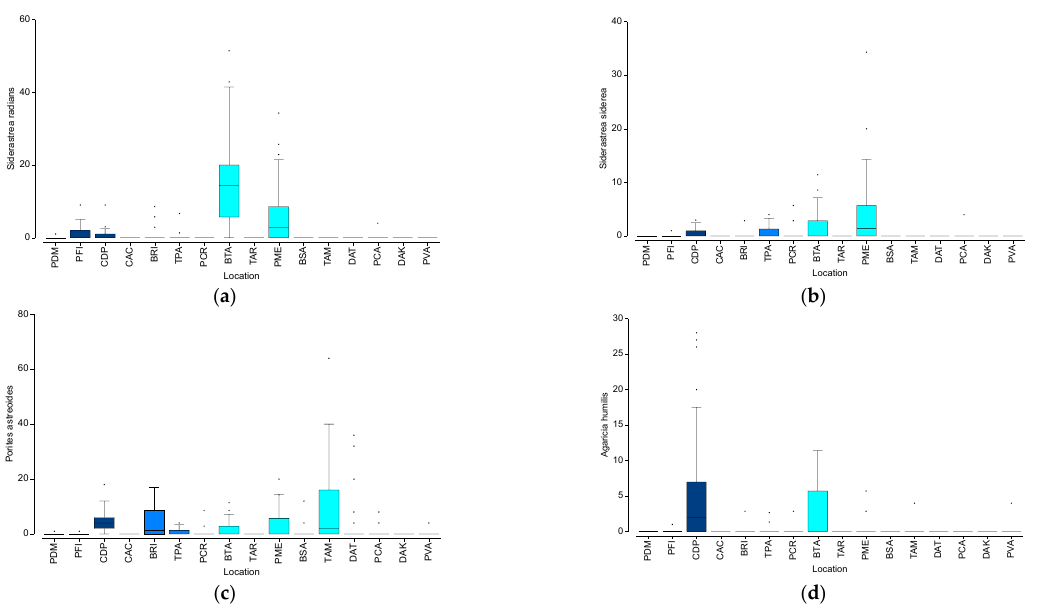
Figure 5. Variation in the spatial patterns in the average density of coral recruits (#/m 2 ) in the four most abundant species: ( a ) Siderastrea radians ; ( b ) S. siderea ; ( c ) Porites astreoides ; and ( d ) Agaricia humilis . Isolated points show outlier values. Refer to the Methodology for the description of acronyms. A PCO analysis yielded five clustering patterns of the spatial organization of coral recruit species richness and described 62% of the observed spatial variation (Figure 6). A first cluster was composed by locations CDP, PME and BTA, which were mostly explained by S. radians , Millepora alcicornis , and Favia fragum recruits. Porites porites , P. astreoides , and A. humilis recruits formed a second cluster composed of TAM and BRI. A third cluster was composed of DAT, PCR, BSA, PCA in Culebra, and by TPA in the western coast, and was dominated by S. siderea , M. complanata , P. furcata , and A. agaricites recruits. A small cluster of PVA and PFI was mostly grouped by A. humilis recruits. A final group formed by CAC, PDM, TAR and DAK showed a very low coral recruit species richness. Spatial patterns in recruit species richness are also detailed in Figure S3.